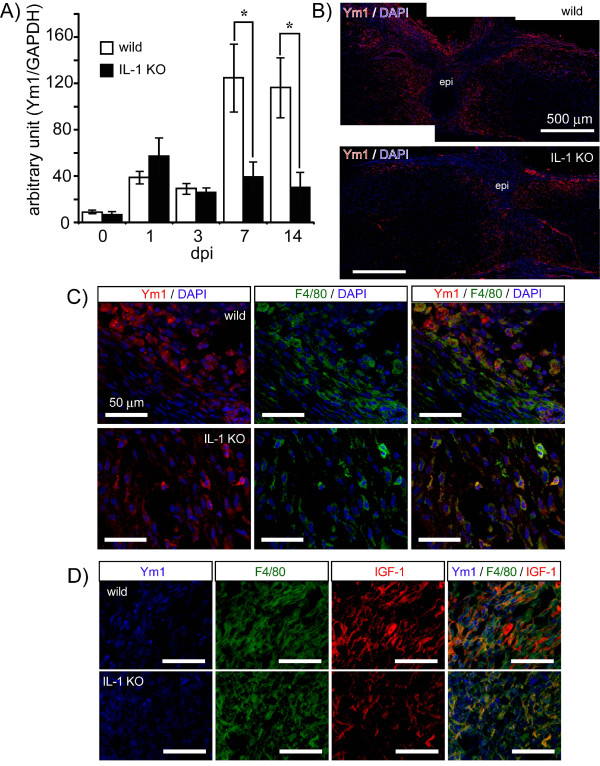
IL-1 KO mice do not exhibit increased expression of the alternative activation marker, Ym1, after SCI. (A) Expression of the marker for alternatively activated microglia/macrophage, Ym1, was semi-quantified by immunoblotting. Ym1 levels in the wild-type mice (n = 6 to 7, open column) were increased on the 7th and 14th dpo. However, the level of Ym1 in the IL-1KO mice (n = 5 to 6, filled column) is significantly lower than that for the wild-type mice. Data are expressed as mean ± SE. *: P <0.05 (Student's t-test). (B) Immunostaining at the 14th dpo for Ym1 in the spinal cord after injury. The immunoreactivity of Ym1 (red) is observed around the lesion epicenter (epi) and is more intense in the wild-type than in IL-1 KO mice. (C) Ym1 immunoreactivity (red) merges with F4/80 immunoreactivity (green, microglia/macrophage marker) in both groups of animals. (D) Moreover, Ym1 (blue) co-localizes with cells that are immunopositive for F4/80 (green) and IGF-1 (red) in both groups. Dpo, days post-operatively; SCI, spinal cord injury.